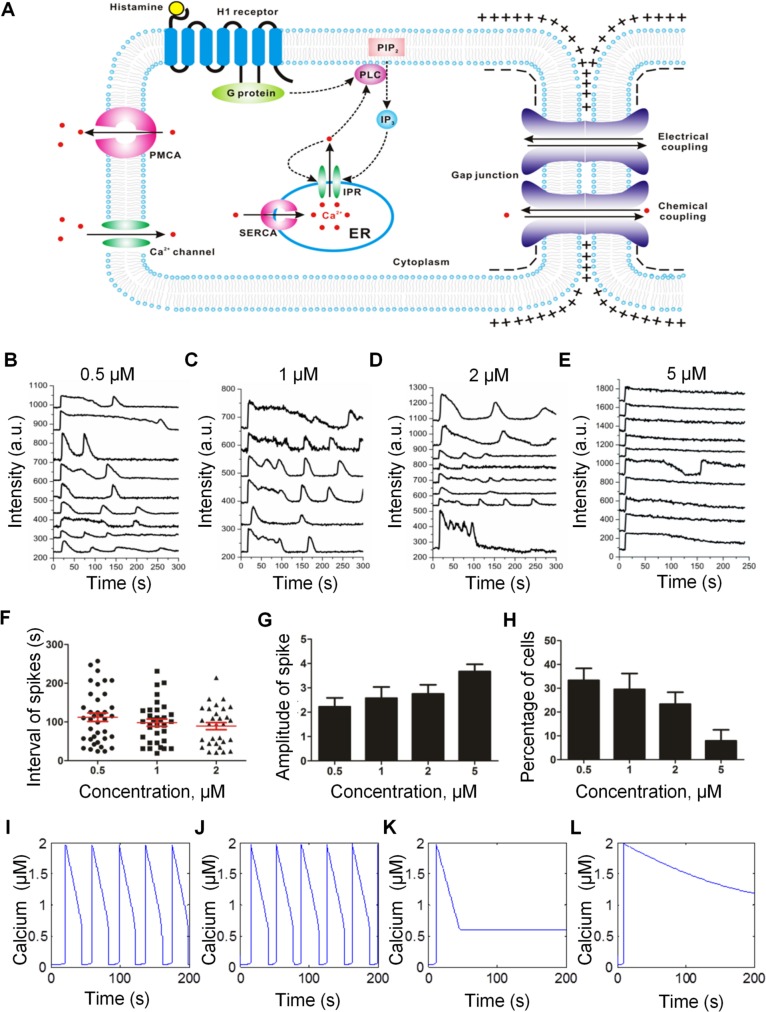
Computational modeling of calcium signaling.(A) Histamine-induced calcium signaling in multicellular systems. Histamine induces the level of inositol 1,4,5-trisphosphate (IP3) via histamine H1 receptor and phospholipase C (PLC) signaling. Sarco/endoplasmic reticulum Ca2+-ATPase (SERCA) and IP3 receptor (IPR) regulate calcium fluxes between the cytosol and the endoplasmic reticulum (ER). Plasma membrane Ca2+-ATPase (PMCA) and calcium channels transport calcium between the cytosol and the extracellular space. With GJIC, the cytosolic calcium concentration can be perturbed by the coupling current due to an imbalance in membrane potential and calcium diffusion due to a concentration gradient. (B-E) Representative calcium dynamics of individual endothelial cells under different concentrations of histamine measured experimentally. The calcium response curves were shifted vertically for clarity. (F) Intervals between the first two spikes in cells exhibiting calcium oscillation. Cells treated with 5 μM histamine were not included due to the small number of cells that exhibit calcium oscillations. (G) Amplitude of calcium pulses at different histamine concentrations. (H) The percentage of cells exhibiting calcium oscillations at different histamine concentrations. Data are representative from three independent experiments. For each independent experiment, ~10 individual cells were analyzed. (I-L) Calcium dynamics of individual endothelial cells under different concentrations of histamine calculated computationally. Parameters applied in the computational models were (I) K = 1 s-1 and Vm3 = 300 s-1; (J) K = 0.75 s-1 and Vm3 = 400 s-1; (K) K = 0.5 s-1 and Vm3 = 500 s-1; (L) K = 0.1 s-1 and Vm3 = 600 s-1 to show the effects of increasing histamine concentration.